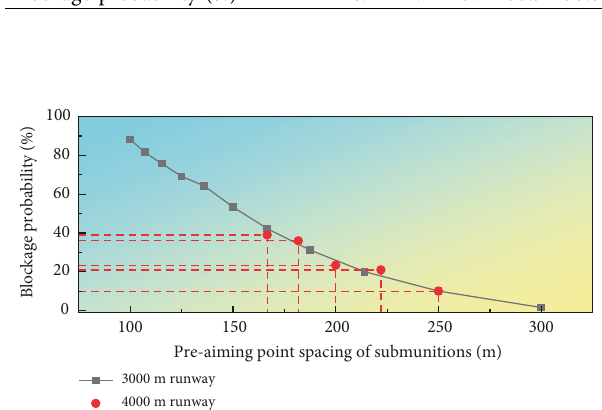
Figure 12: Influence of the number of submunitions on the blockage probability.